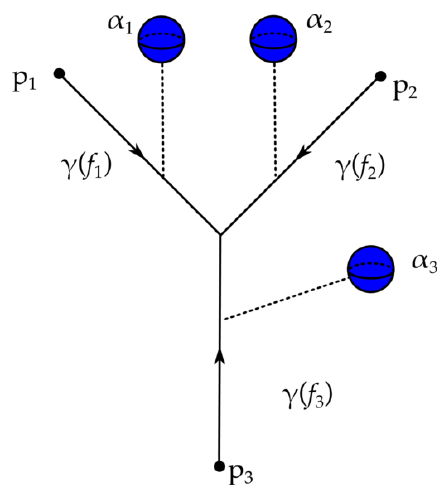
Figure 7 . Gradient (cid:13)ow tree for Yukawa couplings. The picture shows three critical points p i of the functions f i of Morse index (cid:22) f ( p i ) = 1. The gradient (cid:13)ow lines (cid:13) ( f i ) of the f i are marked i by arrows. Every f i controls the size of a 2-cycle (cid:11) i which has the topology of a two-sphere and collapses over the points p i . The three three-chains formed by (cid:12)bering the two-spheres (cid:11) i over the segments (cid:13) ( f i ) can be joined at their meeting point as (cid:11) 1 + (cid:11) 2 + (cid:11) 3 = 0, and the resulting three-cycle is an associative.